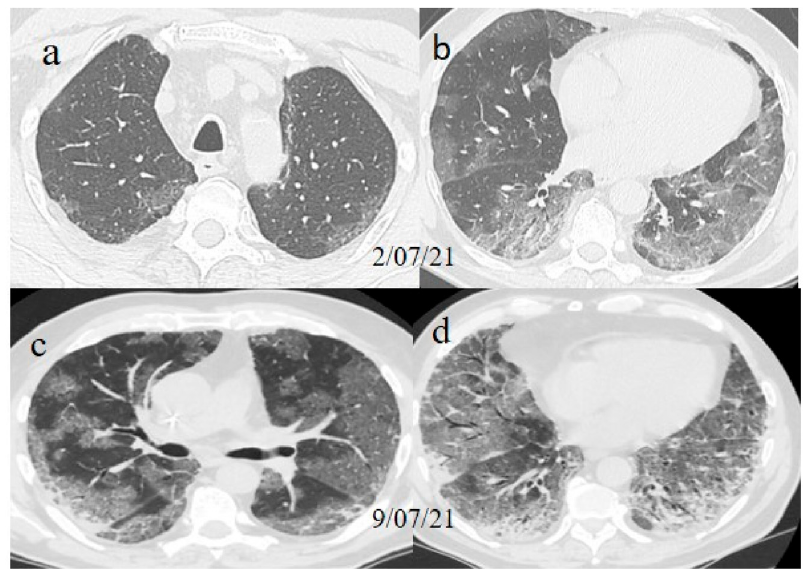
Figure 1. ( a , b ) The basal CT with GGO in a typical peripheral and posterior distribution of COVID- 19 pneumonia with a CT-SS of 13/20. ( c , d ) The chest CT performed 1 week later, showing more extensive pneumonia with a CT-SS of